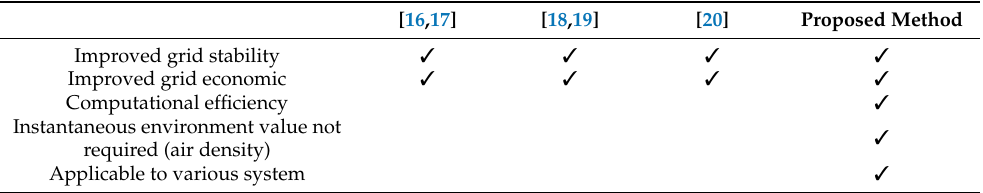
Table 1. Comparison of the proposed method with other wake